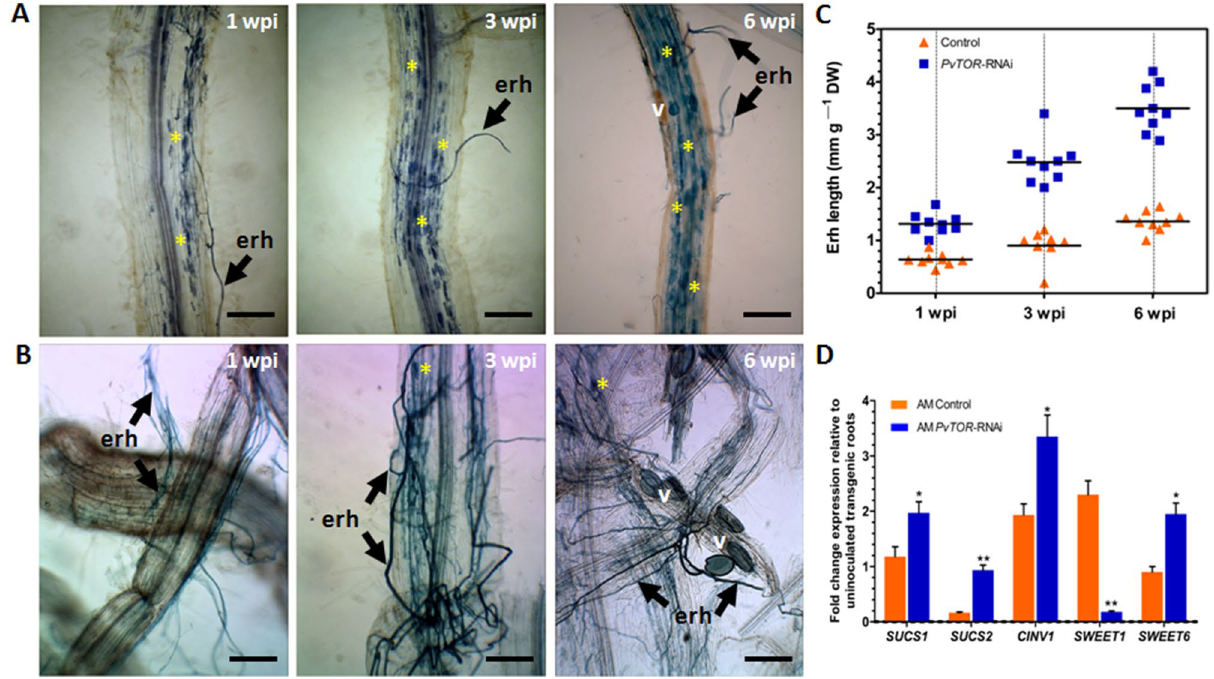
Figure 4. Arbuscular mycorrhizal extraradical hyphae in P. vulgaris PvTOR -RNAi roots. ( A–B ) Transgenic root surface showing extraradical hyphae of mycorrhiza in control ( A ) and PvTOR -RNAi ( B ) plants at 1, 3, and 6 week(s) post inoculation (wpi) with R. irregularis . Arbuscule containing cells are indicated with an asterisk. erh, extraradical hyphae; v, vesicle. Bars = 2 mm. ( C ) Length of arbuscular mycorrhizal extraradical hyphae relative to the dry weight of transgenic roots at 1, 3, and 6 wpi with R. irregularis . n = 9 plants per time point for each line (AM control and AM PvTOR -RNAi). ( D ) RT-qPCR analysis of the transcript levels of sugar metabolism and sucrose transport genes in control and PvTOR -RNAi transgenic roots at 1 wpi with R. irregularis . Data are the fold-change expression relative to uninoculated transgenic roots. Transcript accumulation was normalized to the expression of EIF4a and IDE , which were used as reference genes. The statistical significance of differences between AM control and AM PvTOR -RNAi roots was determined